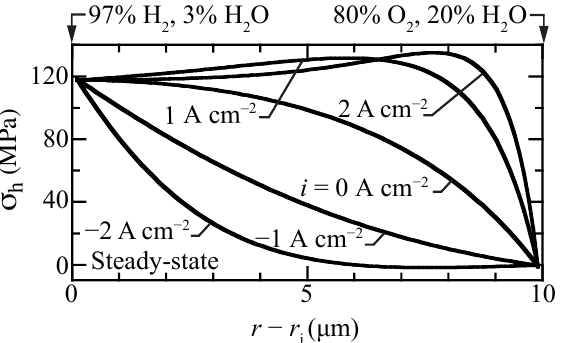
Figure 7. Steady-state hydrostatic stress profiles for selected current densities with the cell operating at 600 ◦ C.